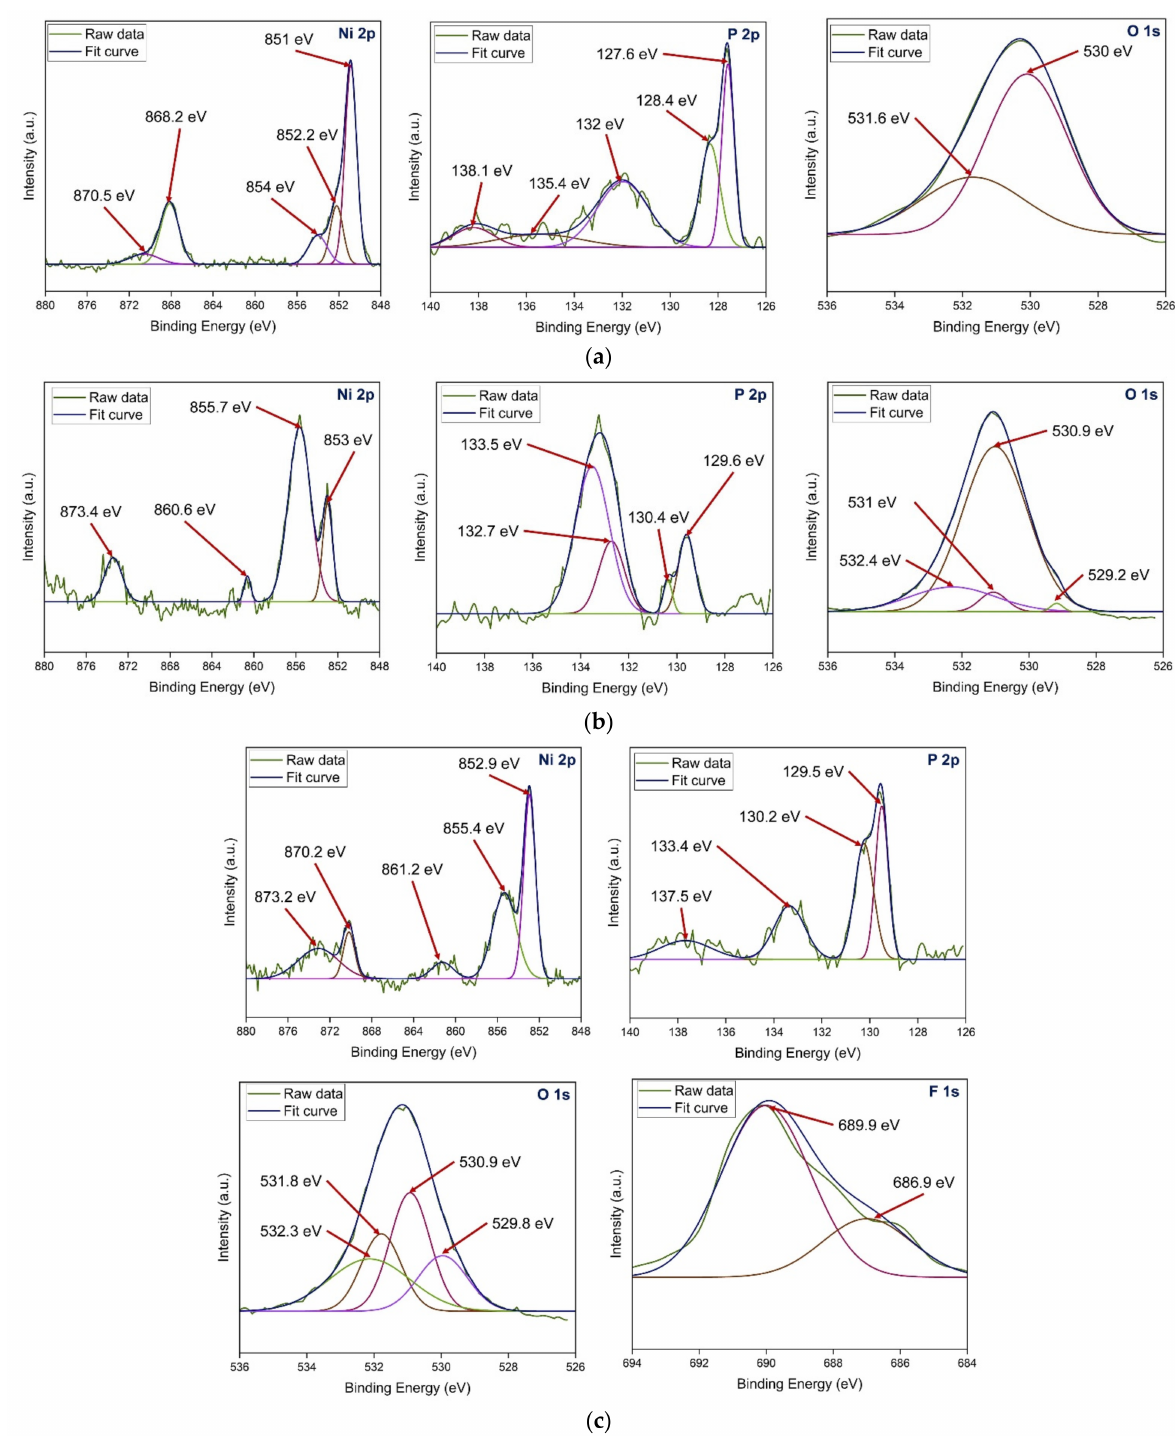
Figure 11. XPS spectra of ( a ) as-plated and chemically surfaces treated with ( b ) H 2 O 2 and ( c ) HF. Figure 11b presents the XPS spectra (Ni 2p, P 2p, and O 1s) of the surface chemically treated with H 2 O 2 . In the Ni 2p spectrum, the peaks observed at 853 eV and 855.7 eV indicate Ni 2p 3/2 and Ni 2 O 3 2p 3/2 , respectively [19]. The other peaks at 860.6 eV and 873.4 eV correspond to NiO 2p 3/2 and Ni 2 O 3 2p 1/2 , respectively [19,31]. In the P 2p spectrum, peaks at 129.6 eV, 130.4 eV, and 133.5 eV correspond to P 2p 3/2 , NiP 2p 1/2 , and P 3+ 2p 3/2 , respectively. The peak at 132.7 eV corresponds to P 2p 1/2 . In the O 1s spectrum, peaks at 530.9 eV, 531 eV, and 532.4 eV correspond to NiO, Ni 2 O 3 , and P 2 O 3 ,